Question: Condense the content of this figure into a single sentence.
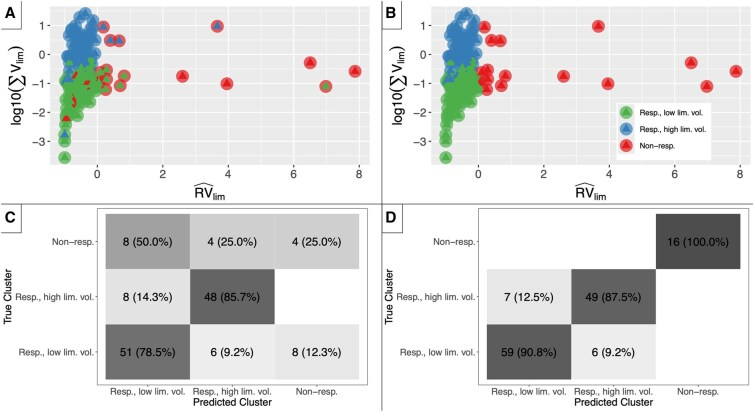
Answer: Prediction of meningioma cluster assignment response. (A) Predicted values (triangles) vs true values (circle) without the variable RVC 3 . (B) Predicted values (triangles) vs true values (circle) without the variable RVC 3 . (C) Confusion matrix without RVC 3 . (D) Confusion matrix with RVC 3 .